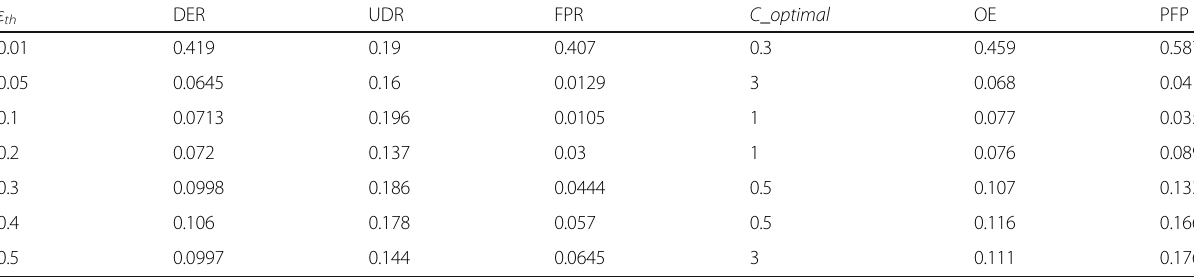
Table 1 Several performance metrics of AdaBoostLSVM classifier with different ε th on the optimal C values ε th